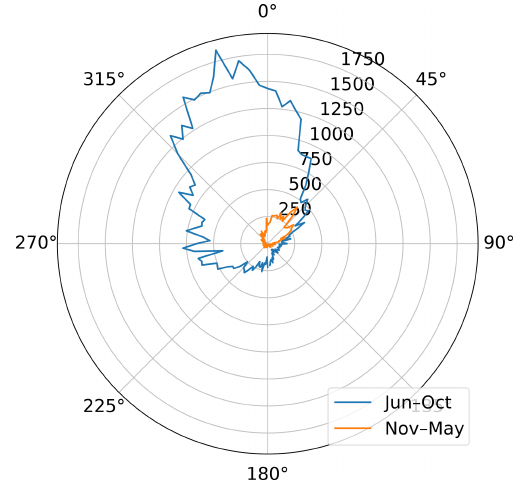
Figure 15. Directional cumulative distribution of propagation direc- tion during June through October versus November through